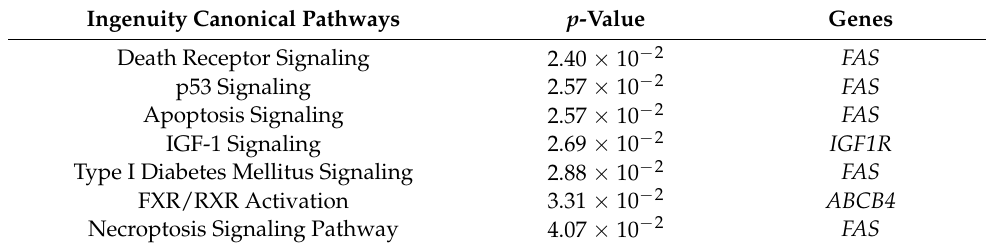
Table A2. Ingenuity Pathway Analysis showing significant (Fisher’s Exact Test p (cid:3409) 0.05) pathways related to the 6 genes found in the molecular databases. These significant pathways are associated with p -values > 0.01.